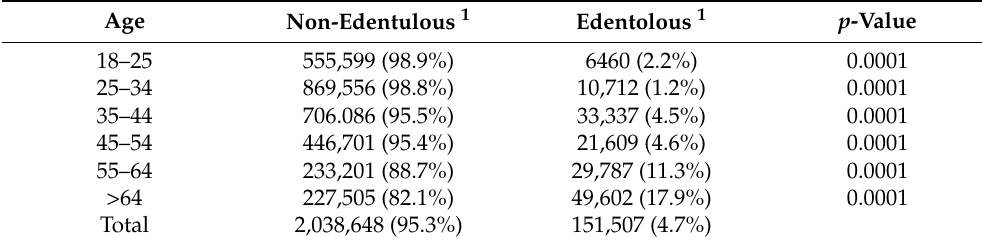
Table 1. Prevalence of edentulism by age in Oaxaca, M é xico according to NPES. Age Non-Edentulous